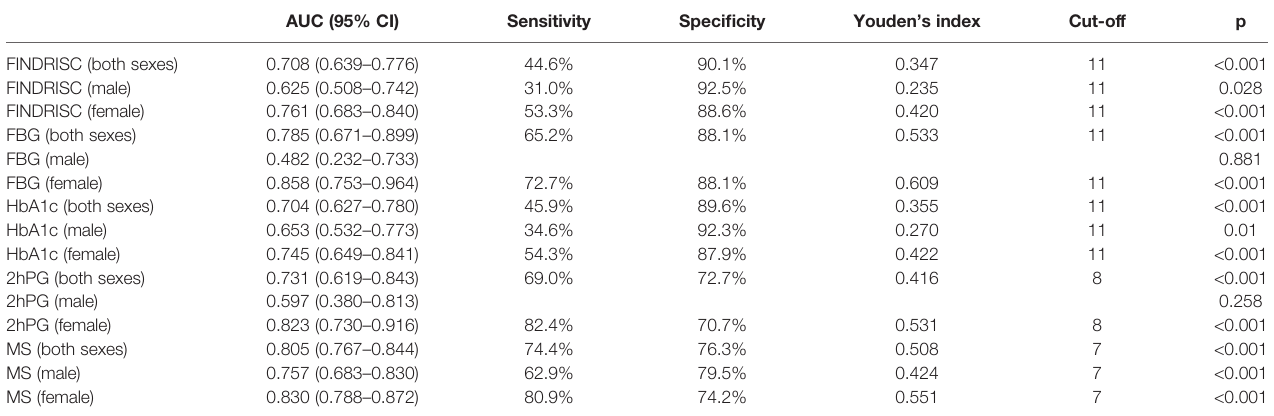
TABLE 6 | FINDRISC area under ROC curve (AUC) for identifying T2DM.